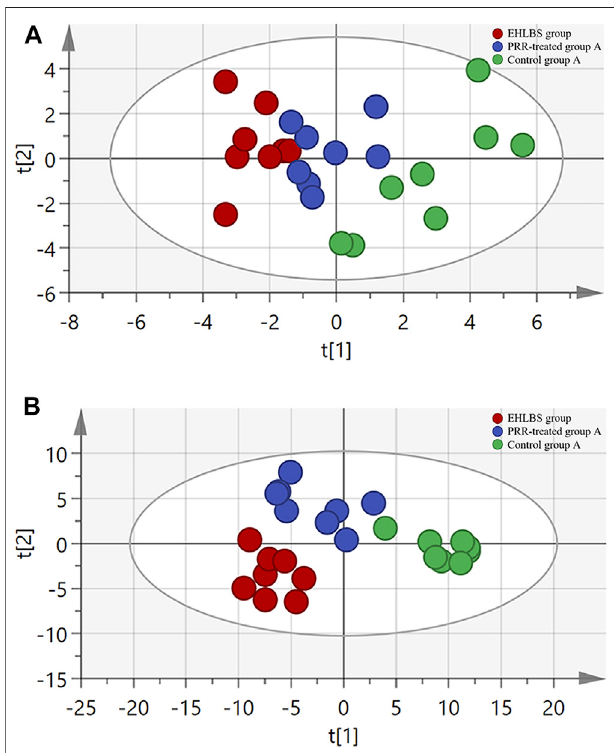
FIGURE 4 | The relationship of metabolic phenotypes among three groups in EHLBS stage. (A) PCA plot. (B) PLS-DA plot. R 2 X and Q 2 Y of PCA are 0.693 and 0.751; R 2 X and Q 2 Y of PLS-DA are 0.705 and 0.869. The CV- ANOVA p value of PLS-DA was less than 0.05.